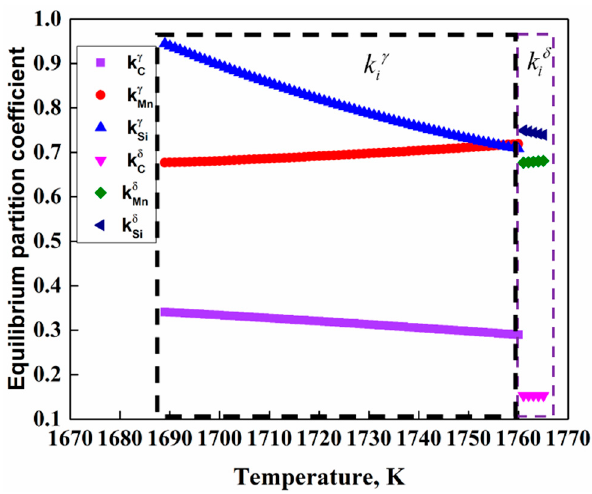
Figure 12. The equilibrium partition coefficient of S50C steel.